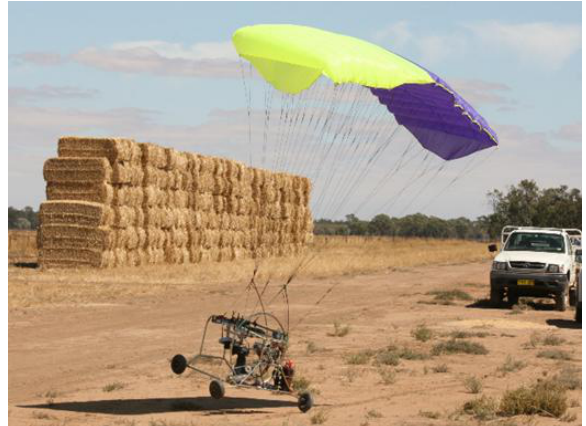
Figure 5. SUSI 62 taking